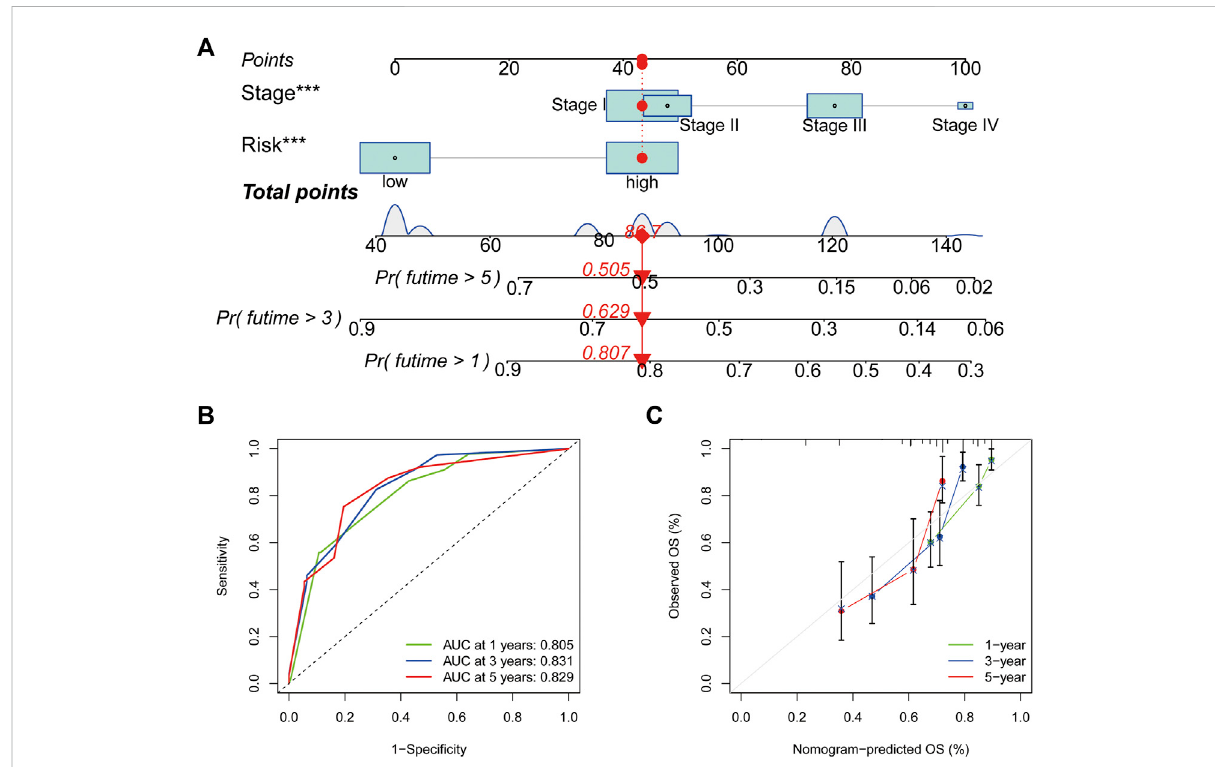
FIGURE 8 Nomogram construction and assessment. (A) Nomogram for predicting the 1-, three- and 5- years survival of patients with hepatocellular carcinoma. (B) Receiver operating characteristic curves of 1-, three- and 5-year survival for the predictive Nomogram. (C) The calibration curves for 1-, three- and 5-year overall survival. * p < 0.05, ** p < 0.01 and *** p <